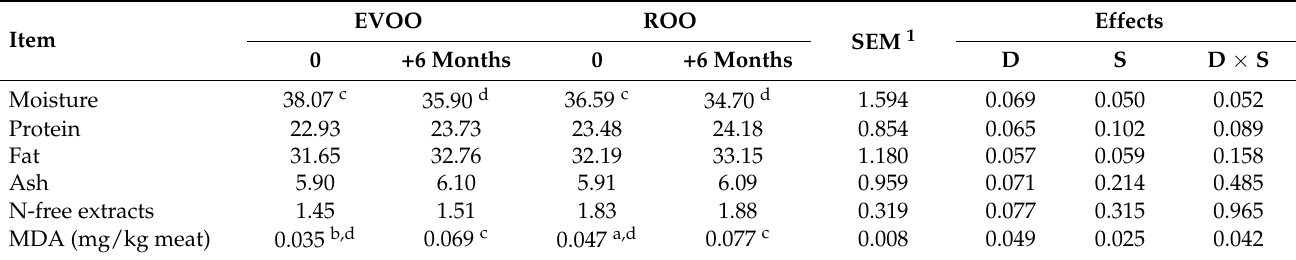
Table 5 shows the results obtained from the chemical analysis of capocollo. As ex- pected, storage for six months lowered ( p < 0.05) the moisture content of capocollo re- gardless of the pigs’ diet. The MDA concentration was greater in the ROO group as compared to the EVOO diet at time 0. Storage determined an increase ( p < 0.05) of the MDA concentration in both dietary groups. Table 5. Effect of the pigs’ diet (EVOO and ROO) and of the storage period (0 and +6 months) on the chemical composition and malondialdehyde (MDA) concentration of Capocollo di Martina Franca dry-cured meat. Item